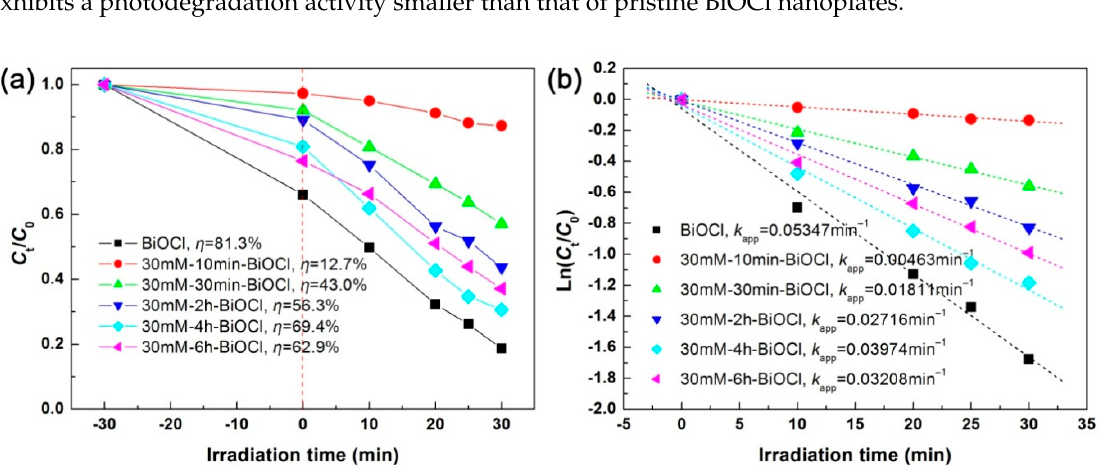
Figure 11. Time-dependent photodegradation of RhB ( a ) and kinetic plots of the dye degradation ( b ) over the 30 mM NaBH 4 -treated BiOCl samples with different treatment times.